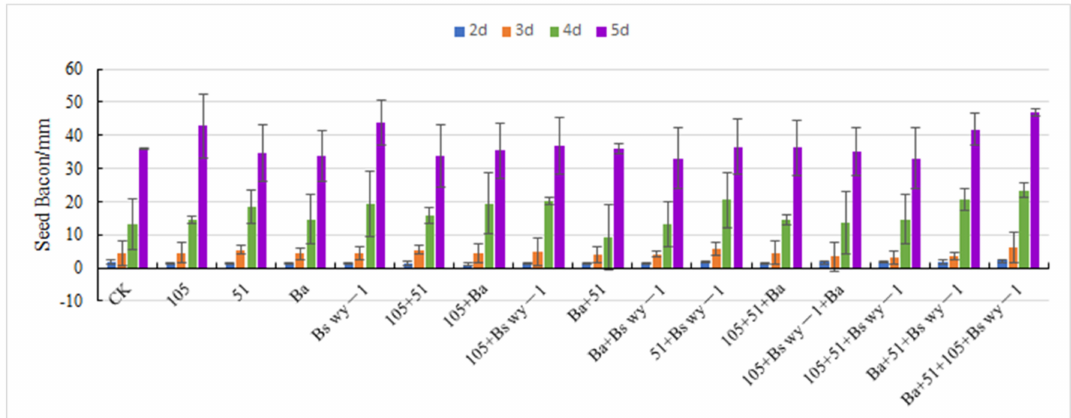
Figure 2. Growth-promoting effect of single and compound combination bacterial liquids on the growth of tomato seed